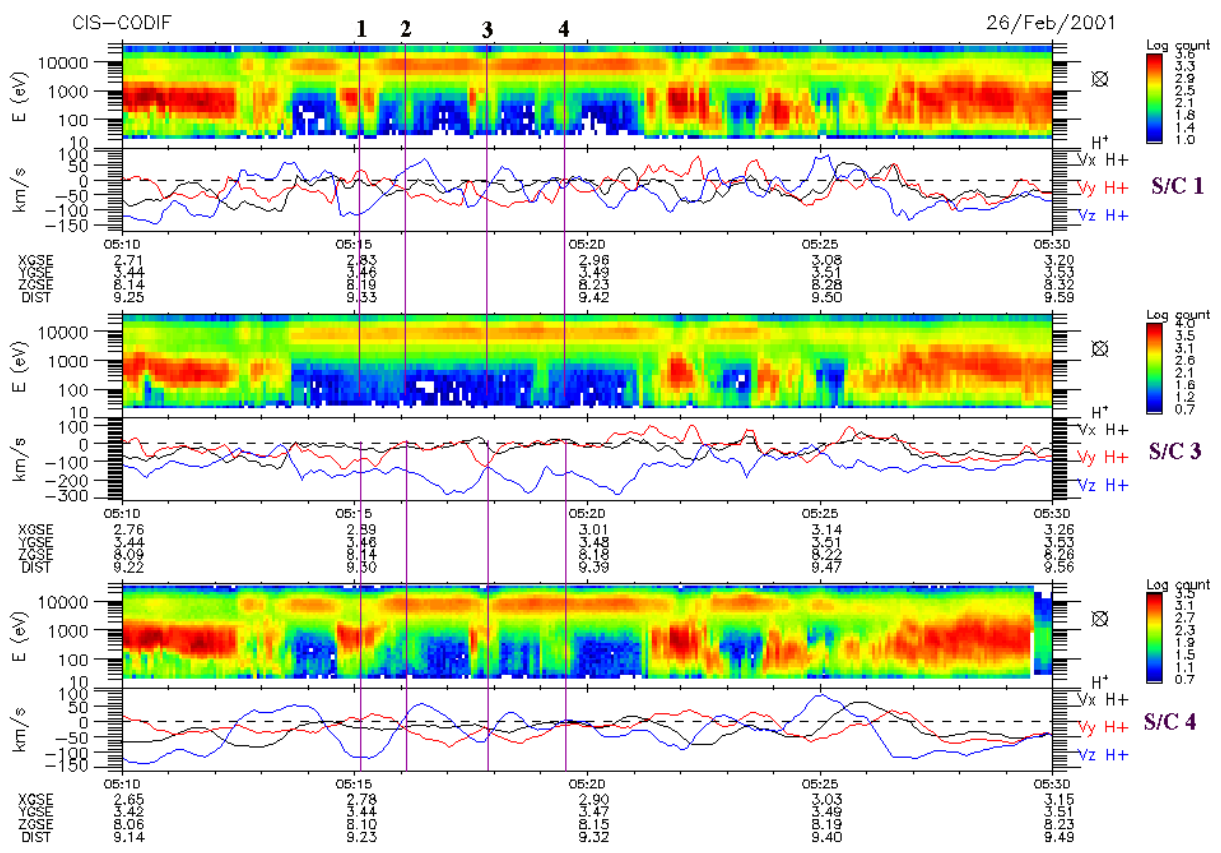
Fig. 1. Cluster CIS data from 26 February 2001, displaying a series of magnetosheath plasma transfer events (marked by (1) , (2) , (3) and (4) ), embedded in a background of more energetic ring current/plasma sheet plasma ( ≈ 05:14–05:21UT). The data were taken during a time when the IMF B z was ≈ 0nT and the IMF B y was ≈−